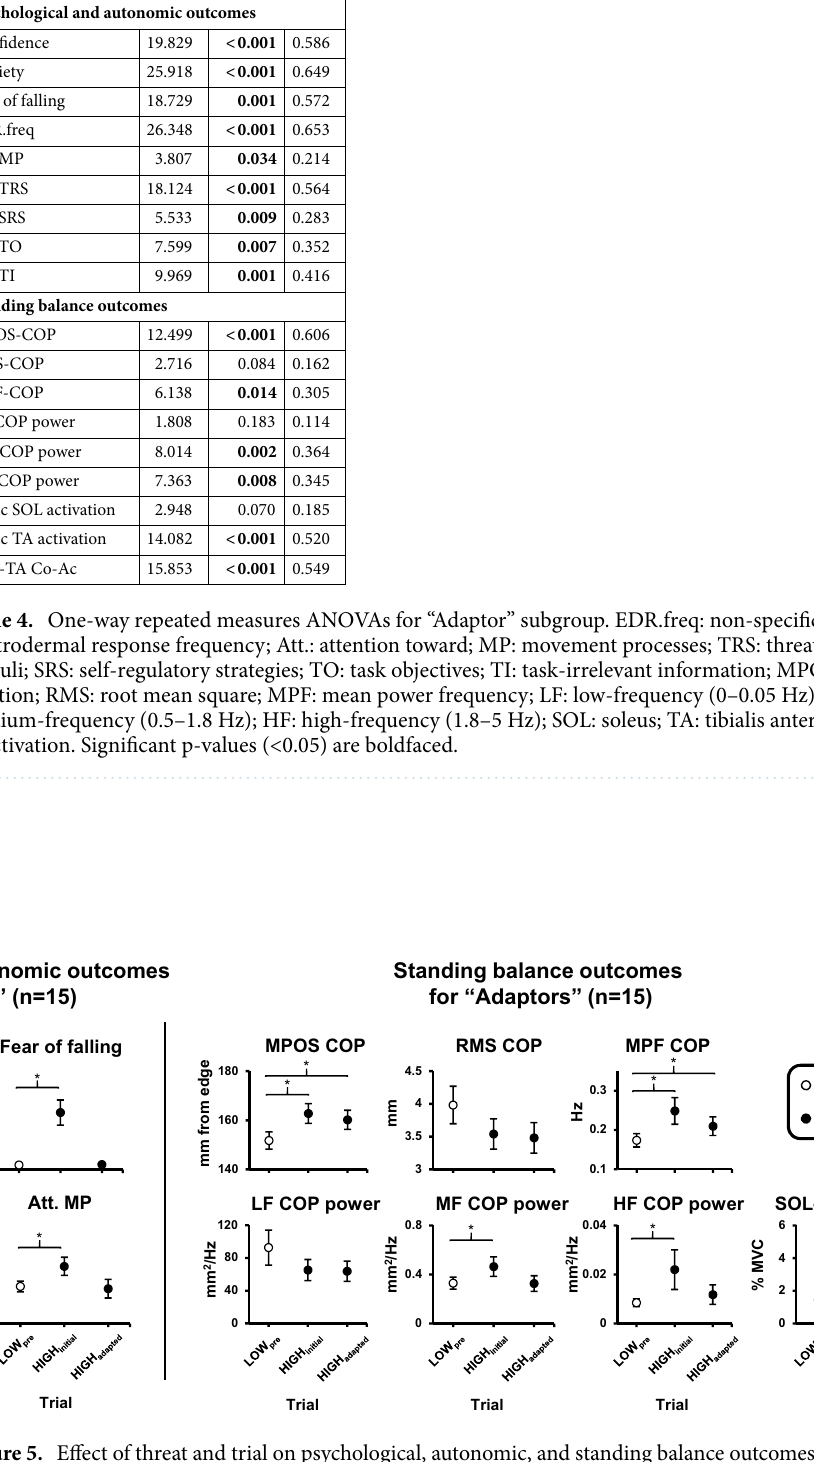
Figure 5. Effect of threat and trial on psychological, autonomic, and standing balance outcomes in the “Adaptor” subgroup (n = 15). Data presented reflect group means and standard errors. The first two LOW trials for each participant were averaged (LOW pre ) and are presented as open circles. The first two HIGH trials for each participant were averaged (HIGH initial ). The trial at which point the participant was identified as an “Adaptor” and the next HIGH trial were averaged (HIGH adapted ). Both HIGH initial and HIGH adapted are presented as filled black circles. Att. MP = attention toward movement processes; COP = centre of pressure; EDR.freq = non- specific electrodermal response frequency; HF = high frequency (1.8–5 Hz); LF = low frequency (0–0.05 Hz); MF = medium frequency (0.5–1.8 Hz); MPF = mean power frequency; MPOS = mean position; RMS = root mean square; SOL-TA = soleus-tibialis anterior; VAS = visual analog scale. Brackets with asterisks indicate significant planned follow-up comparisons (p <